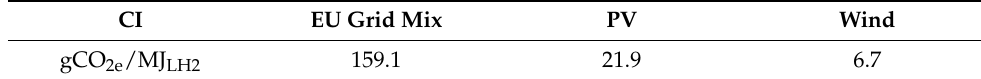
Table 3. Carbon Intensity of LH 2 .